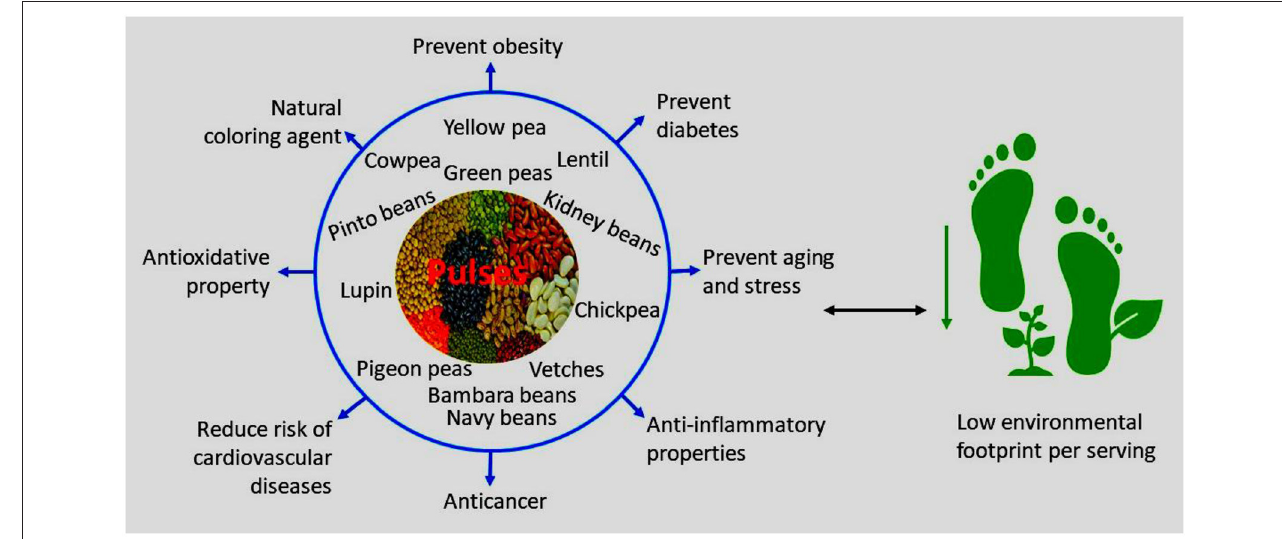
FIGURE 1 | Benefits of pulse consumption on health and the